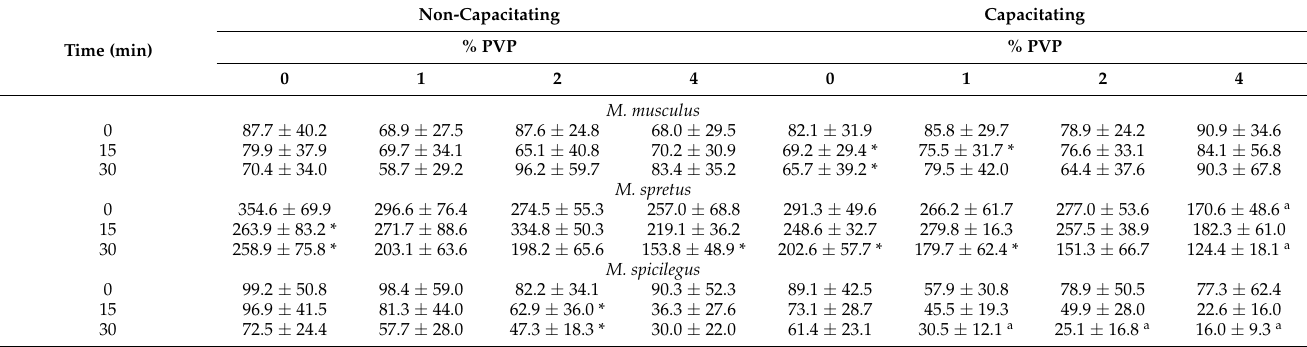
Table 4. Effect of various concentrations of PVP on ATP levels in spermatozoa from three mouse species incubated for different lengths of time under non-capacitating conditions (mT-H medium under air) or capacitating conditions (mT-BH medium under 5%CO 2 /air). ATP values correspond to ATP amount per sperm (amol spz − 1 ). Means ± SE ( M. musculus : N = 4; M. spretus : N = 7; M. spicilegus : N = 7) are reported. Letters in the same row indicate significant differences between different PVP concentrations and control (0% PVP) in Tukey’s post-hoc test ( a : p < 0.05). Asterisks in the same column indicate significant differences between times in comparison to time 0 for the same PVP concentration in Tukey’s post-hoc test ( p <